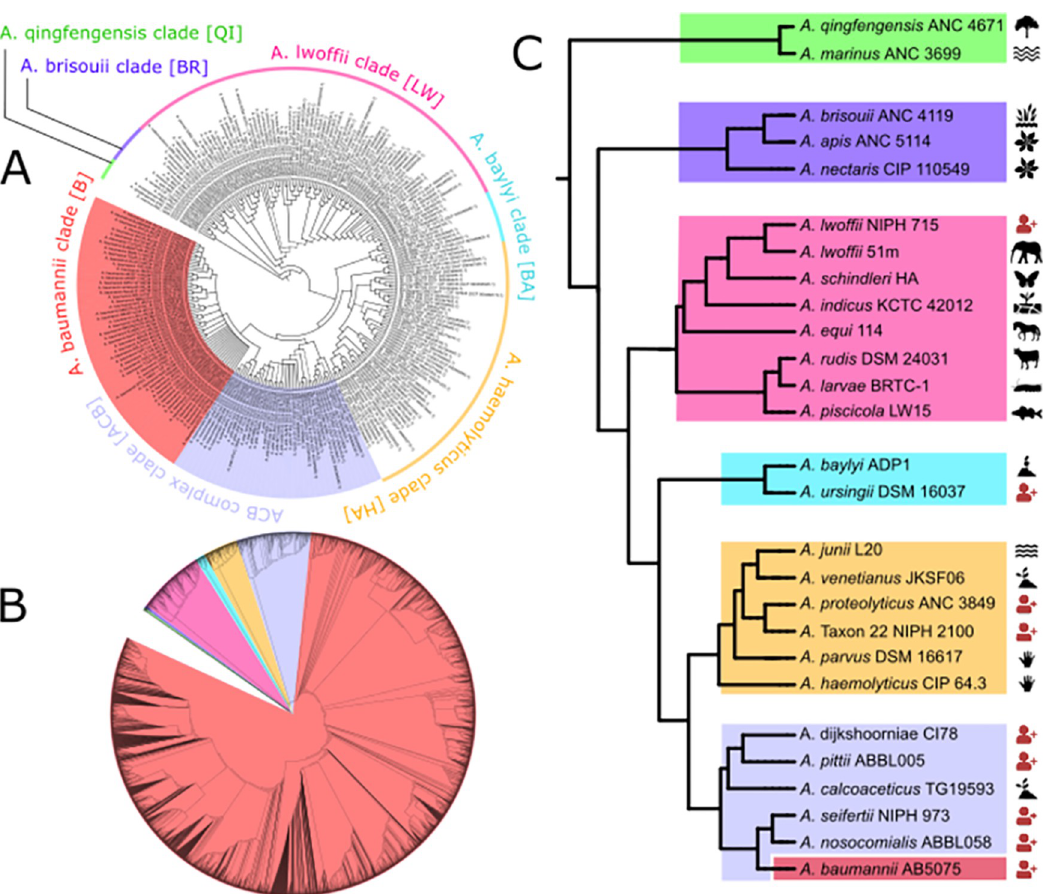
Fig 2. The phylogeny of the genus Acinetobacter. (A) Majority-rule consensus phylogeny of 232 Acinetobacter strains represented in SET-R. Solid branches are supported by all, and hatched branches by two out of three trees. A high-resolution image of this tree is provided in S2 Fig. (B) The maximum likelihood tree for all 3052 taxa in Set-F. Colored clades represent the same clades as in A). A high-resolution image of this tree is provided in S3 Fig. (C) The evolutionary backbone of the Acinetobacter genus with exemplary strains as clade representatives. The color scheme resembles that of Fig 2A. The pictograms next to the leaf labels indicate the sampling source of the particular strain. Red pictograms signal a strain that was isolated from an infected patient. The clipart used in this figure has been dedicated to the public domain (CCO 1.0 Universal) or was